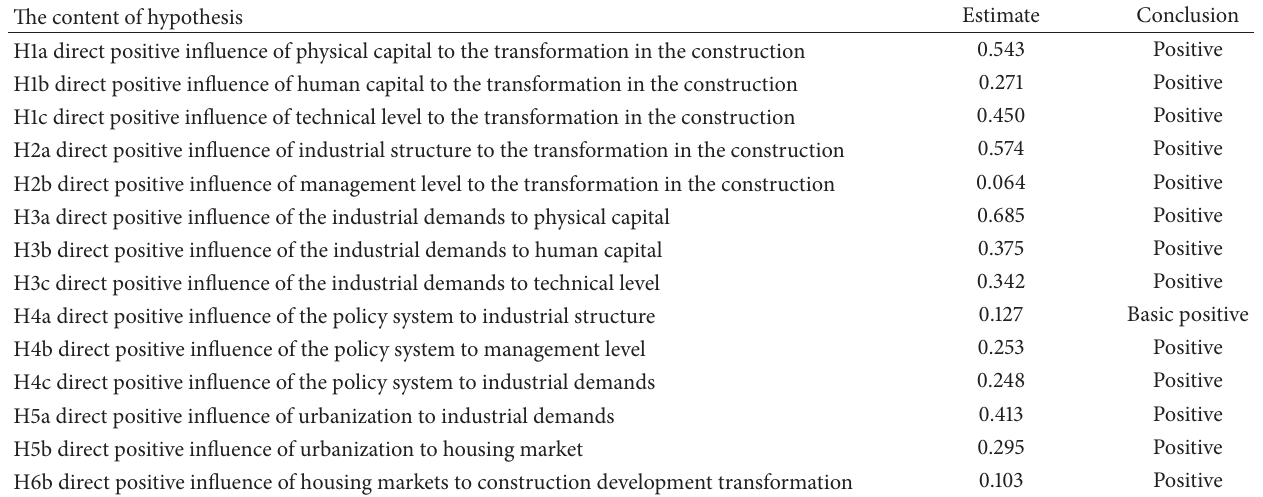
Table 7: Hypothesis testing results.